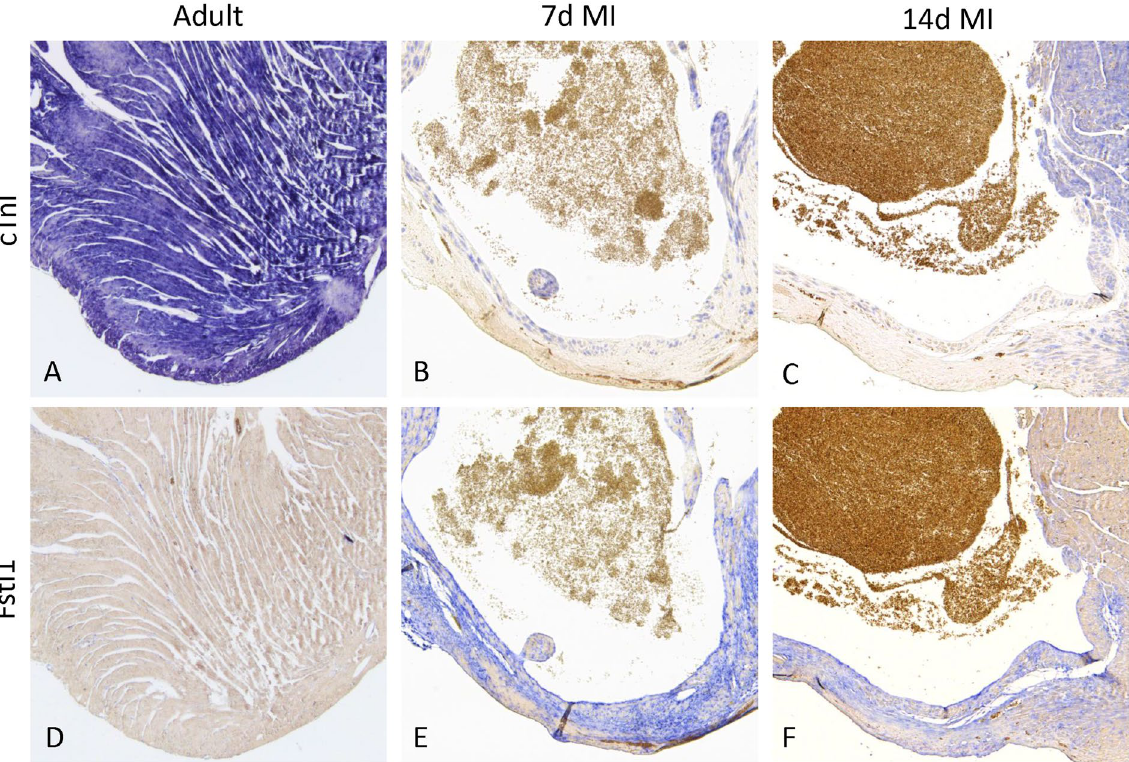
Figure 2. Fstl1 expression in the mouse heart after myocardial infarction (MI). In situ hybridization on sections was performed to visualize the expression of cTnI and Fstl1 in control ventricle ( A and D ) and after induced myocardial infarction ( B , E , C and F ). The infarcted area is identified by the absence of cTnI expression ( B and C ). Fstl1 expression is low in control heart ( D ) and highly expressed in the infarcted area at 7 days ( E ) and 14 days ( F ) after myocardial infarction (7d MI and 14d